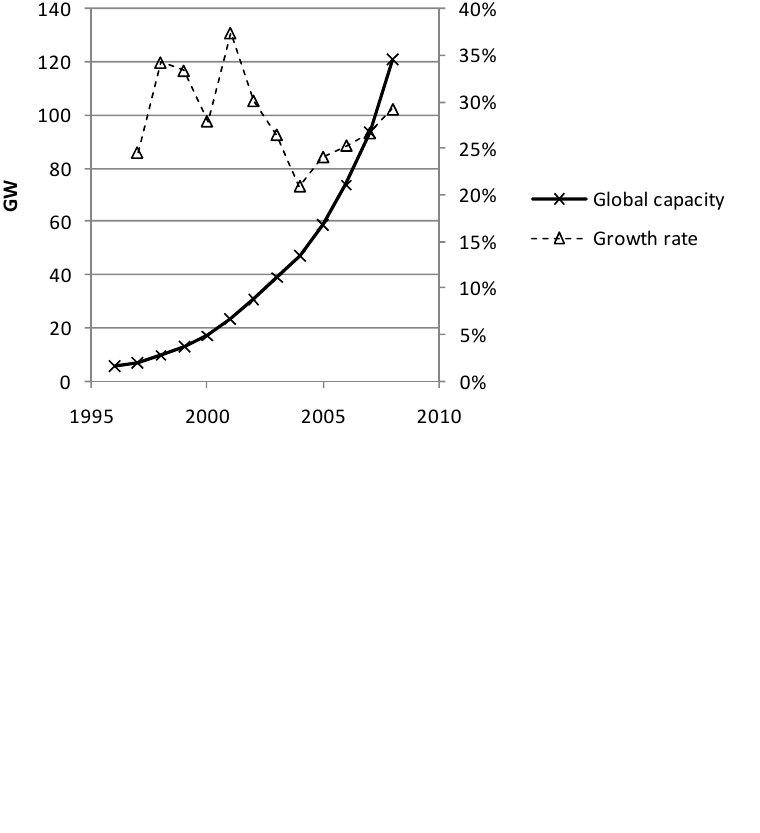
Figure 41. Historical development of installed wind power capacity, and annual growth rates (compiled from